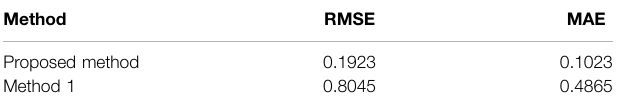
TABLE 2 | Prediction performance of different